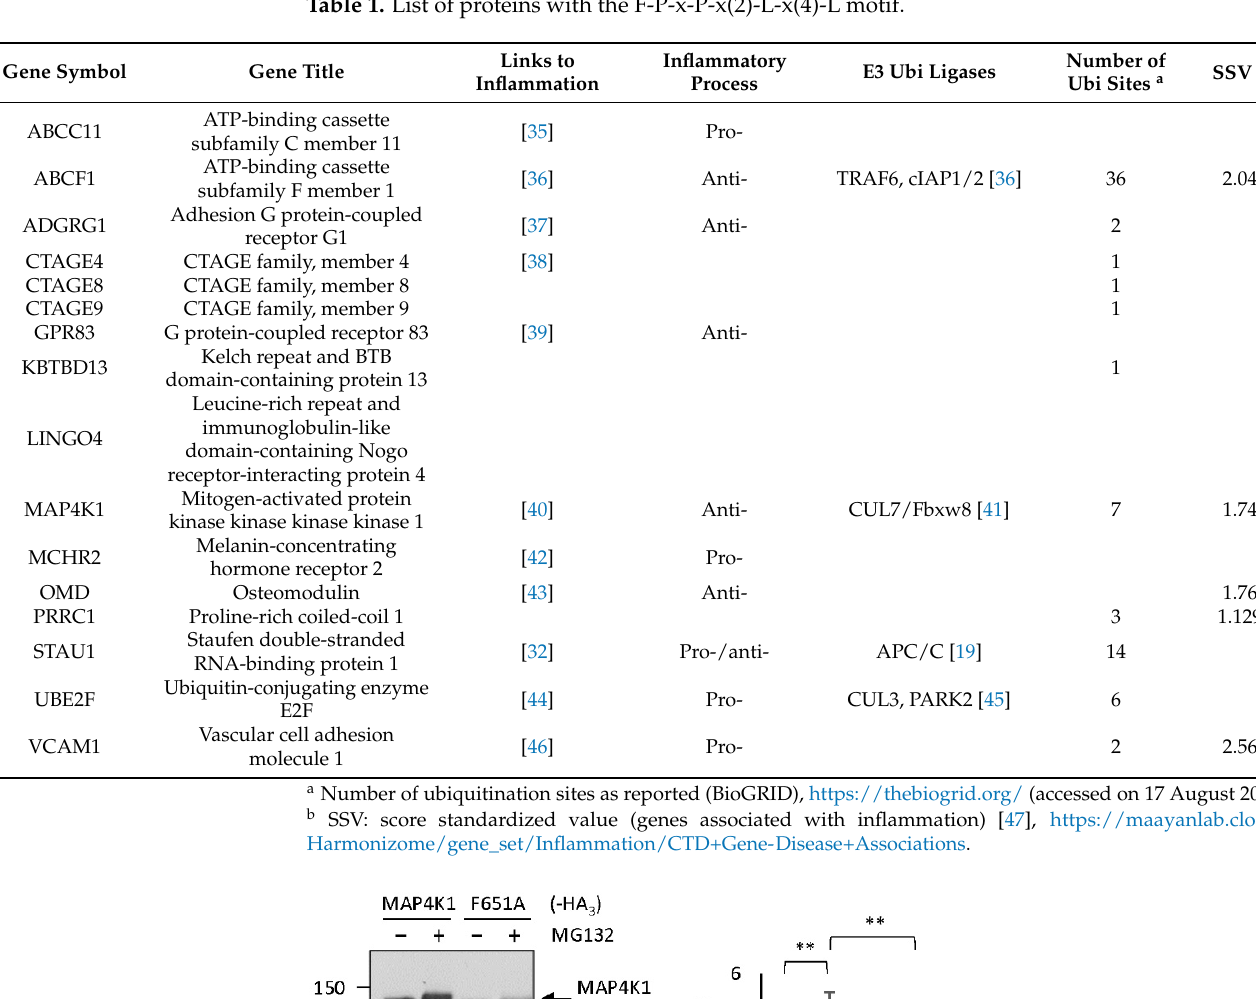
Table 1. List of proteins with the F-P-x-P-x(2)-L-x(4)-L motif.